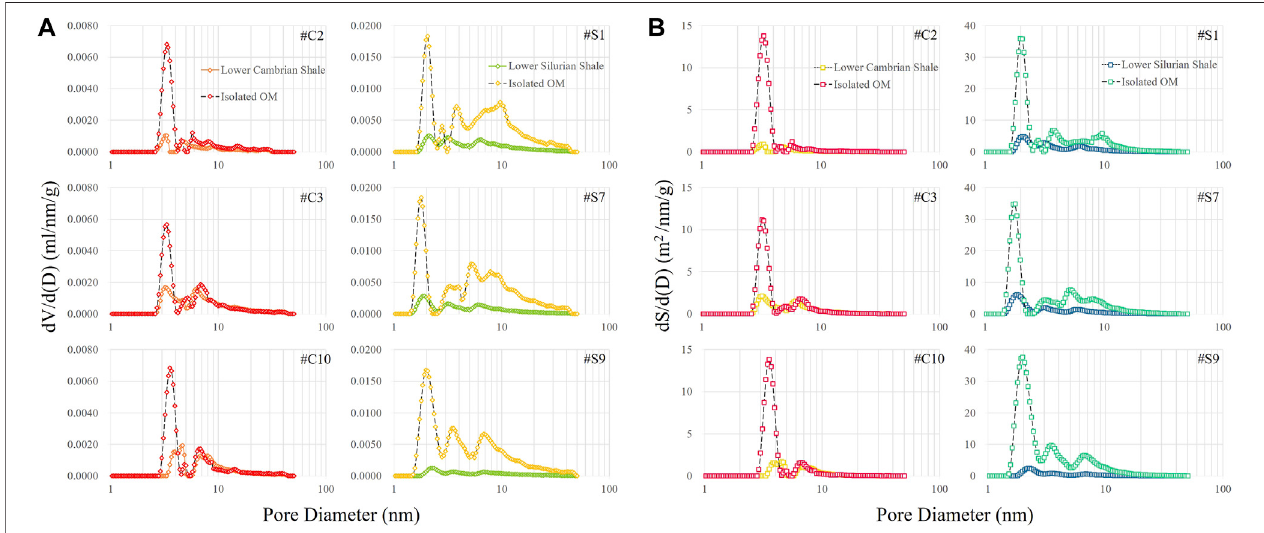
FIGURE7|(A) RelationshipsbetweenporevolumesandporesizedistributionsofisolatedOMsandcorrespondingbulksamplesfromtheLowerCambrianshales (#C2, #C3 and #C10) and the Lower Silurian shales (#S1, #S7 and #S9). (B) Relationships between pore surface areas and pore size distribution of isolated OMs and corresponding bulk samples from the Lower Cambrian shales (#C2, #C3 and #C10) and Lower Silurian shales (#S1, #S7 and #S9).